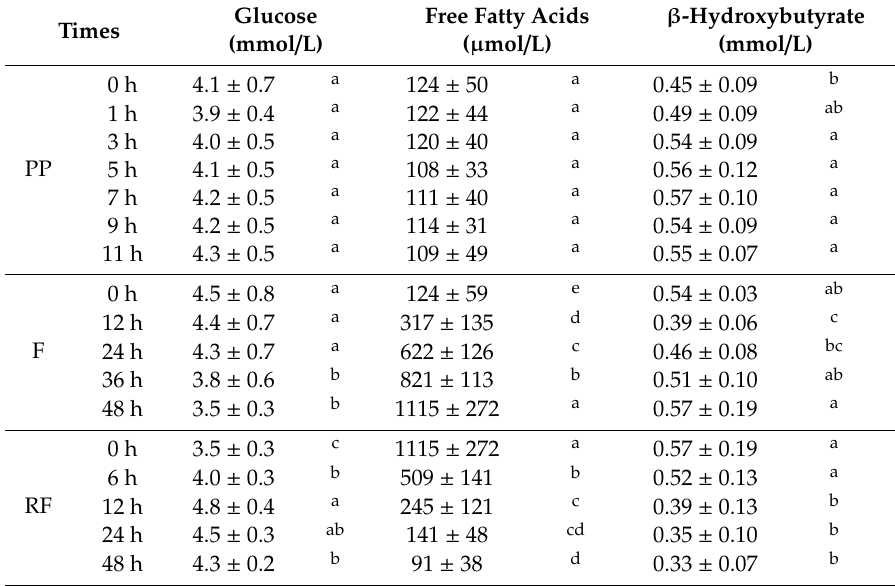
Distinct letters ( a , b , c , d , e , ab , bc ) in the same column indicate significant di ff erences within the same physiological period ( p <